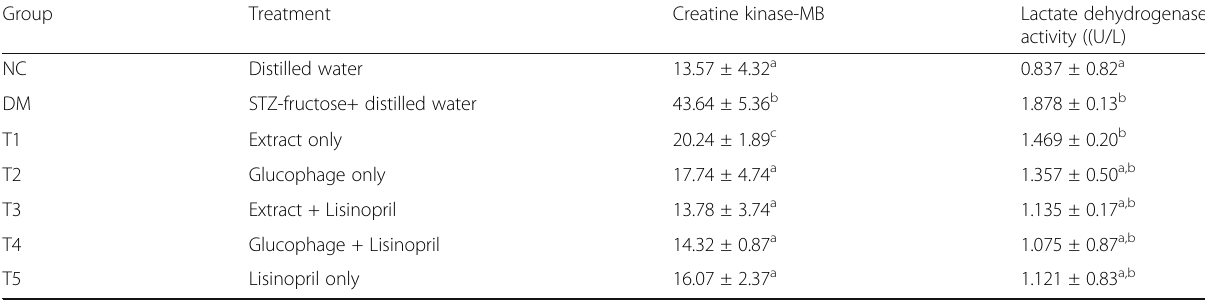
Table 4 Effect of combined administration of lisinopril and ethanolic bark extract of E. chlorantha on serum CK and LDH activities Group